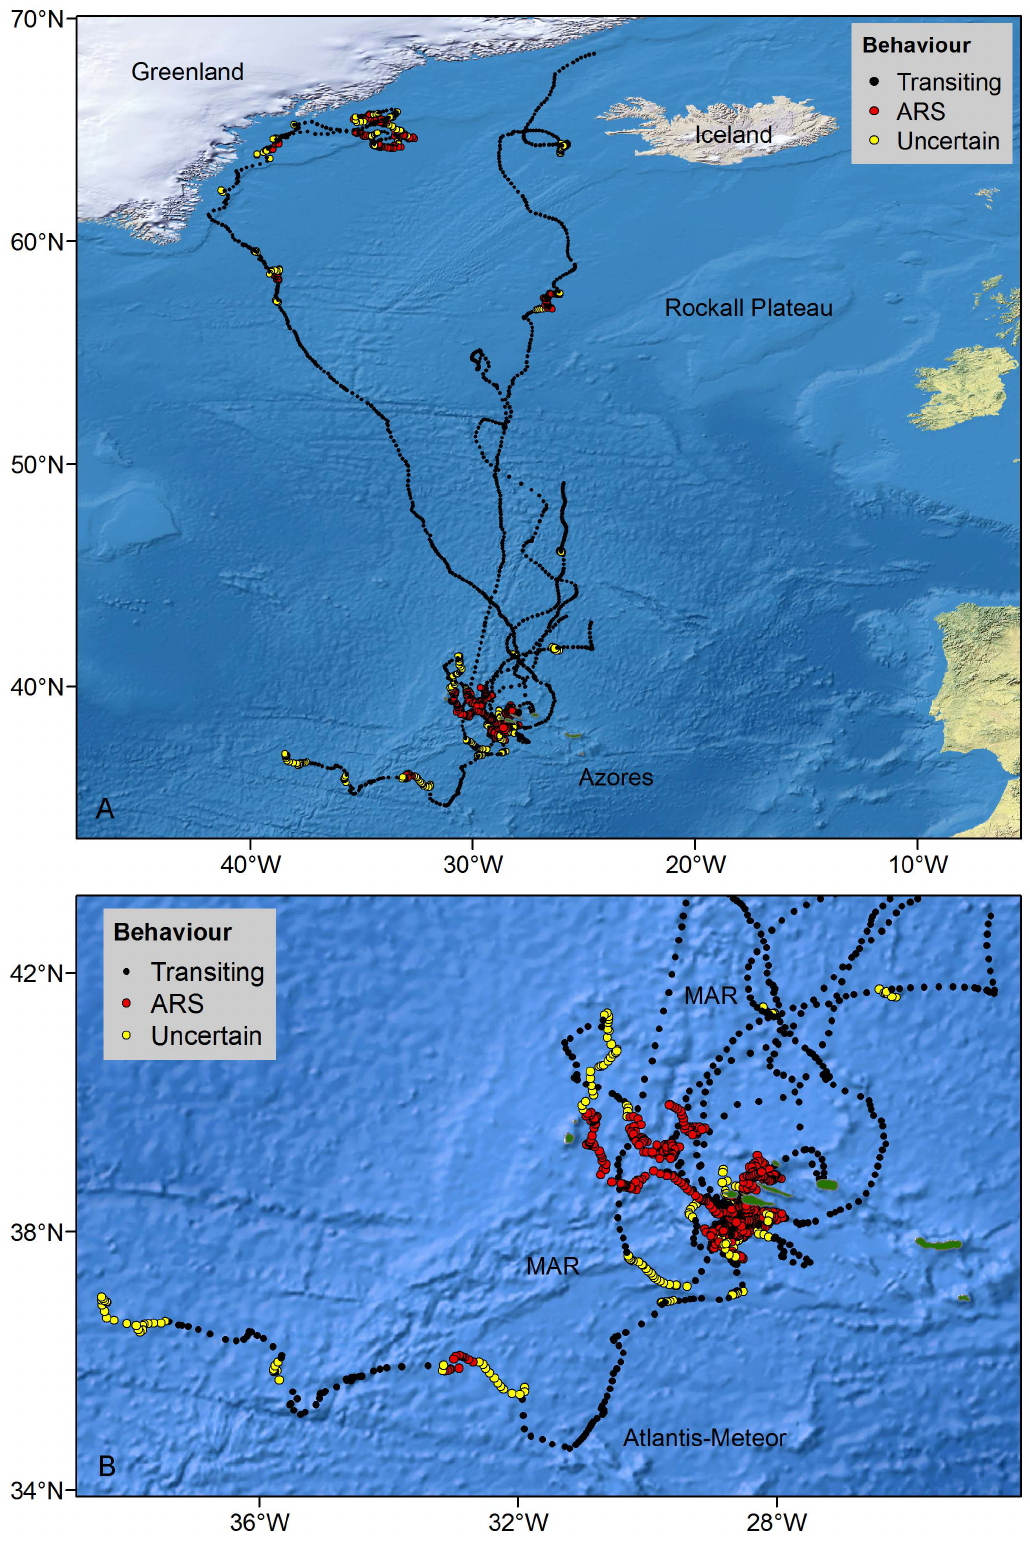
Figure 3. Hierarchical switching state-space model derived locations of fin whales showing inferred behavioural modes. A. Complete tracks. B. Details of the tracks at middle latitudes, showing the location of the Mid-Atlantic Ridge (MAR) and the Atlantis-Meteor seamount complex.